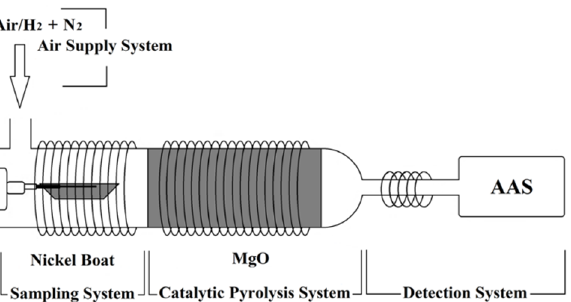
Figure 6. Comparison of Cd concentrations measured by the ETV-AAS and microwave digestion GF-AAS methods.